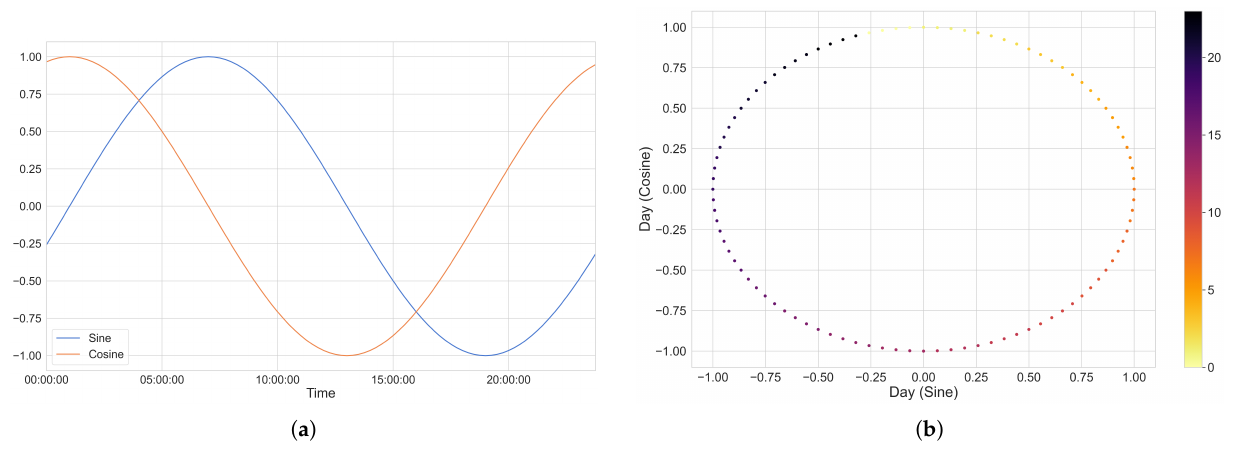
Figure 3. By utilizing a combination of the sine function and the cosine function, we eliminated the possibility that two different times would receive the same value had we used either function independently. The combination of both functions can be thought of as an artificial 2-axis coordinate system that represents the time of day. ( a ) The time of the day represented as a combination of both sine and cosine waves. ( b ) Visualizing our cyclical encoding of the time of